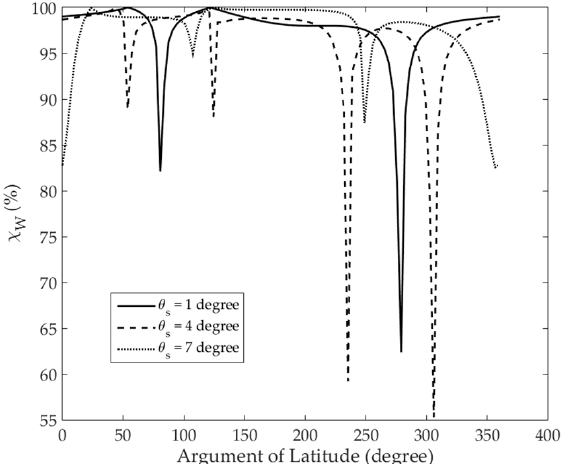
Figure 4. Values of ratio χ W , defined in Equation (5), obtained with different squint angles θ s , which include 1, 4, and 7 degrees. Because of the high orbital height, the maximum value of θ s is approximately 7° for GEO SAR.